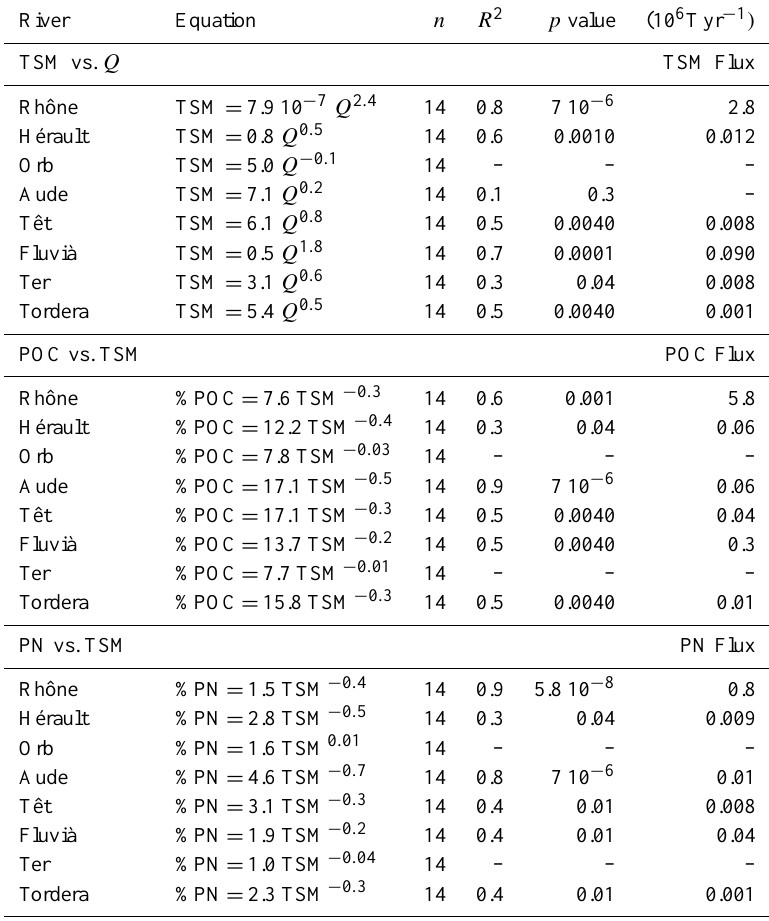
Table 3. TSM and POC annual estimated fluxes (2008–2009) of each studied river calculated from 14 samples using power equations: TSM = a × Q b , POC% = a × TSM b and PN% = a × TSM b , where a and b are regression coefficients. Fluxes are only calculated in rivers with a statistically significant p value ( p <